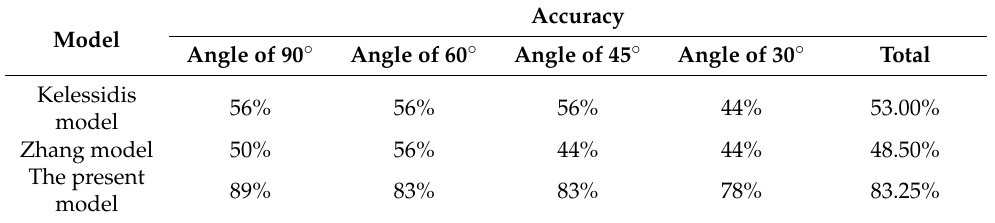
Table 6. Results of model